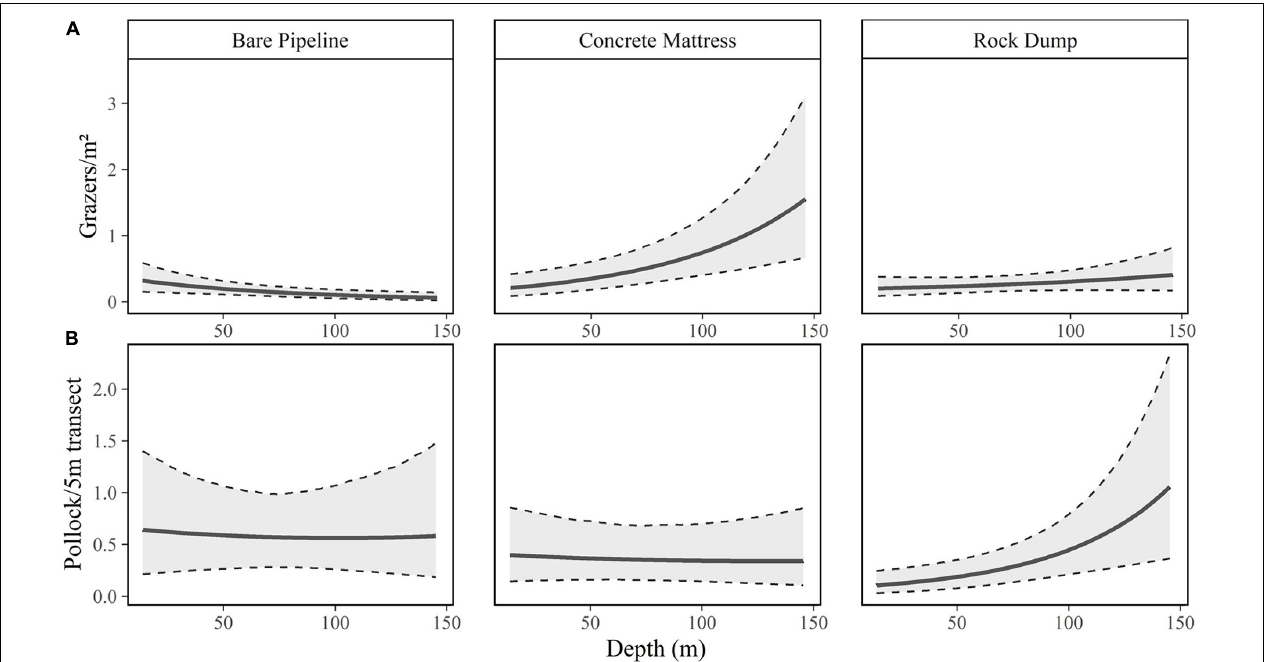
FIGURE 3 | Modelled relationships and 95% CrI’s between (A) grazer abundance per 1 m 2 , (B) pollock abundance per 5 m transect with depth (m) according to protection type. TABLE 1 | Percent rate of change (with 95% CrI) in relation to a 10 m increase in depth, depending on protection type. Taxa group Bare pipeline Concrete mattress Rock dump